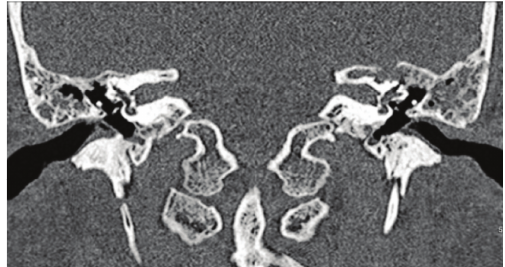
Figure 2: Note the erosion in the bone covering the superior semicircular canal and arcuate eminence as well as petrous bone.